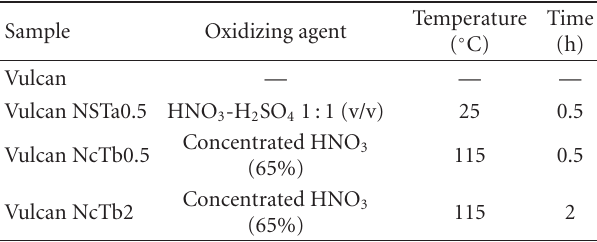
Table 1: Nomenclature of functionalizated Vulcan